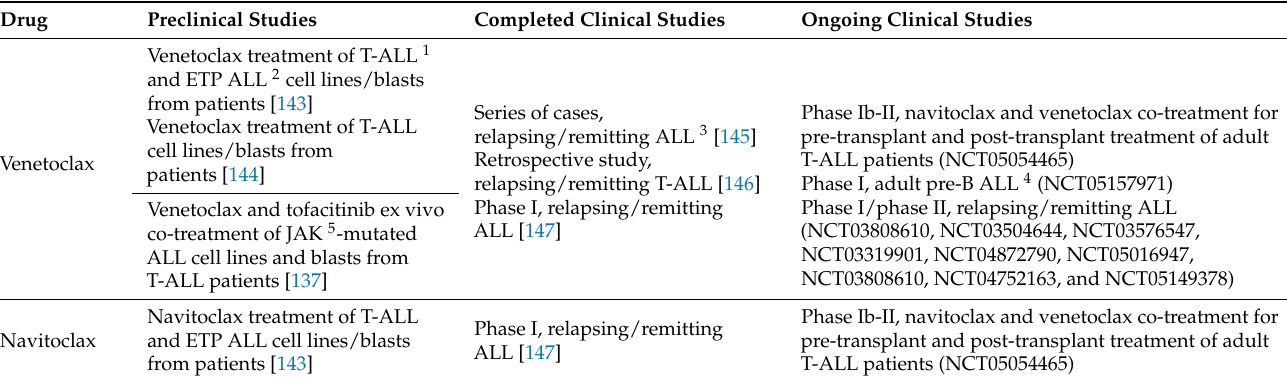
Table 2. BH3 mimetics in ALL